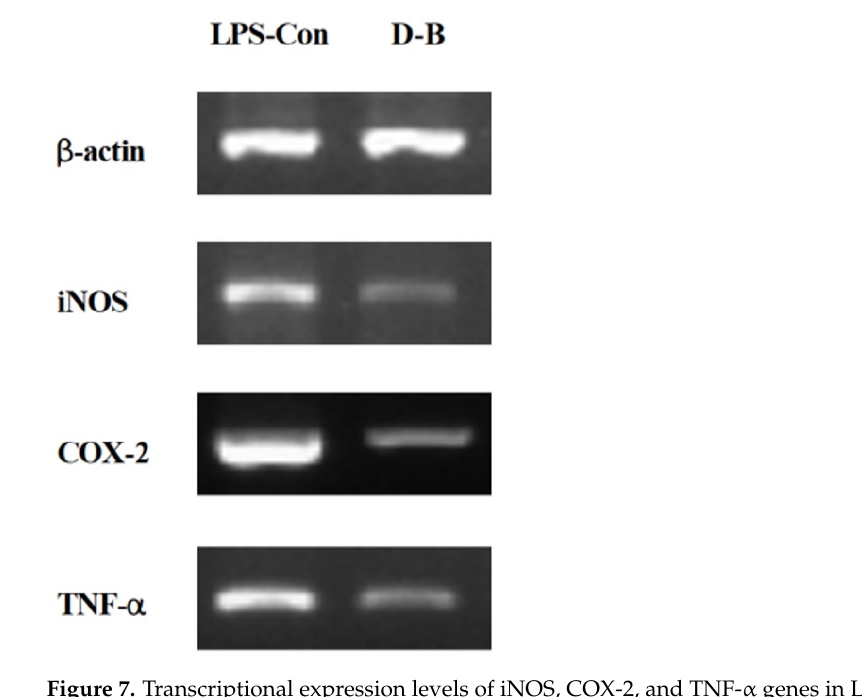
Figure 7. Transcriptional expression levels of iNOS, COX-2, and TNF- α genes in LPS-induced Raw 264.7 cells with underground parts extracts of Dachul. LPS-con; Control, D-B; Dachul grown under LED-Blue